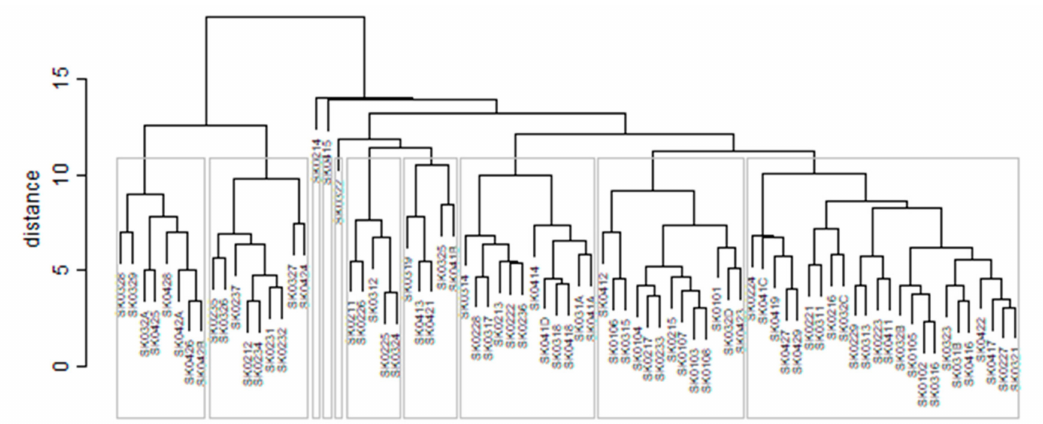
Figure 17. Preventable mortality dendrogram of the districts for the female sex in the whole explored period. Source: own elaboration by the authors.